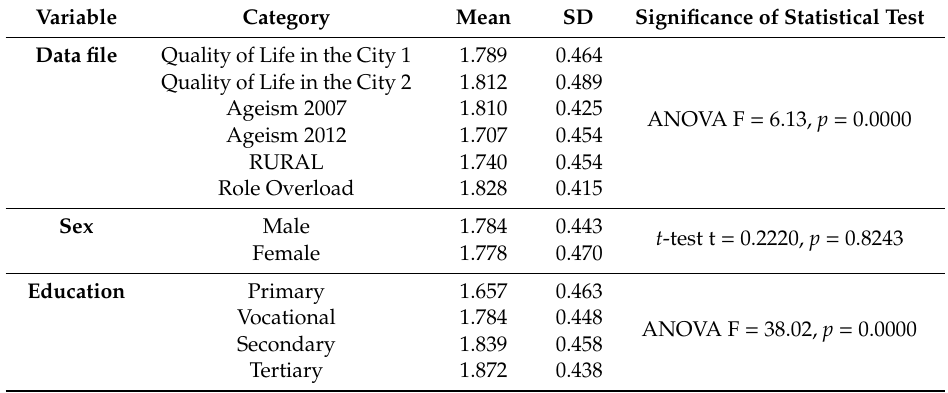
Table 2. The di ff erence in the mean POLA scale according to the survey, sex, and education.